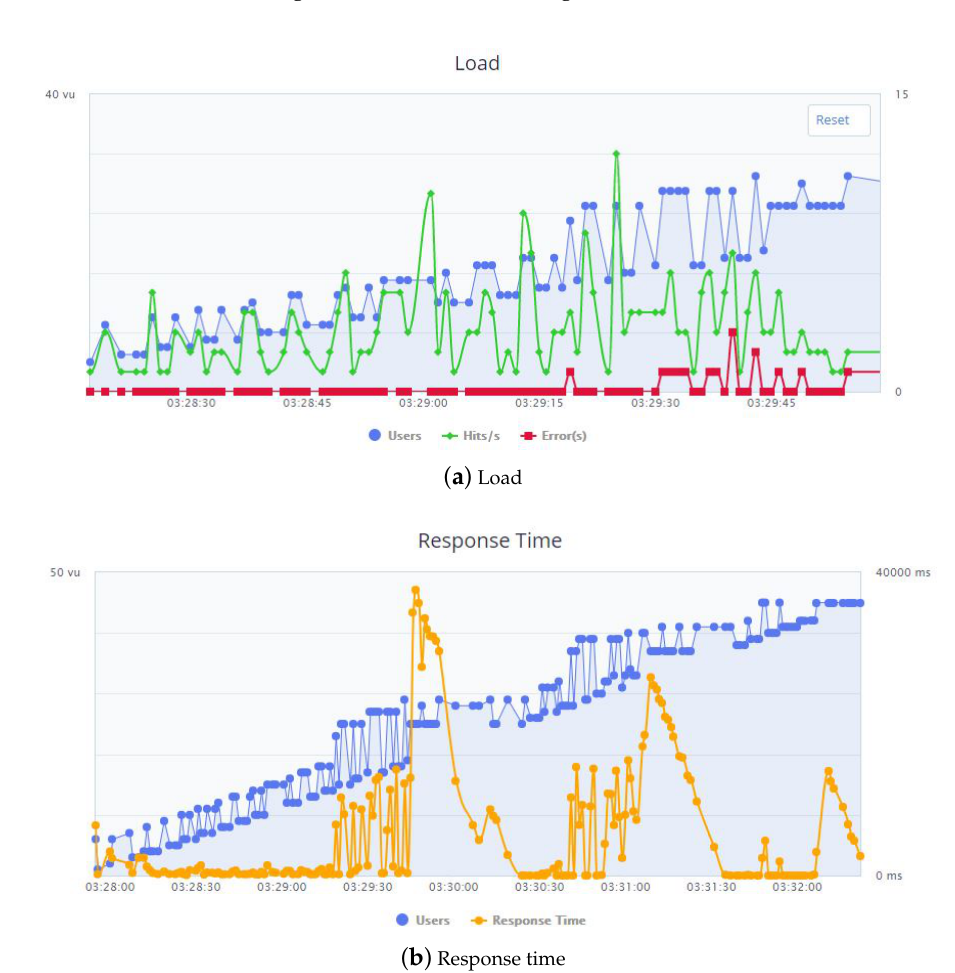
Figure 18. Load and performance testing under peak conditions for simultaneous 40 virtual